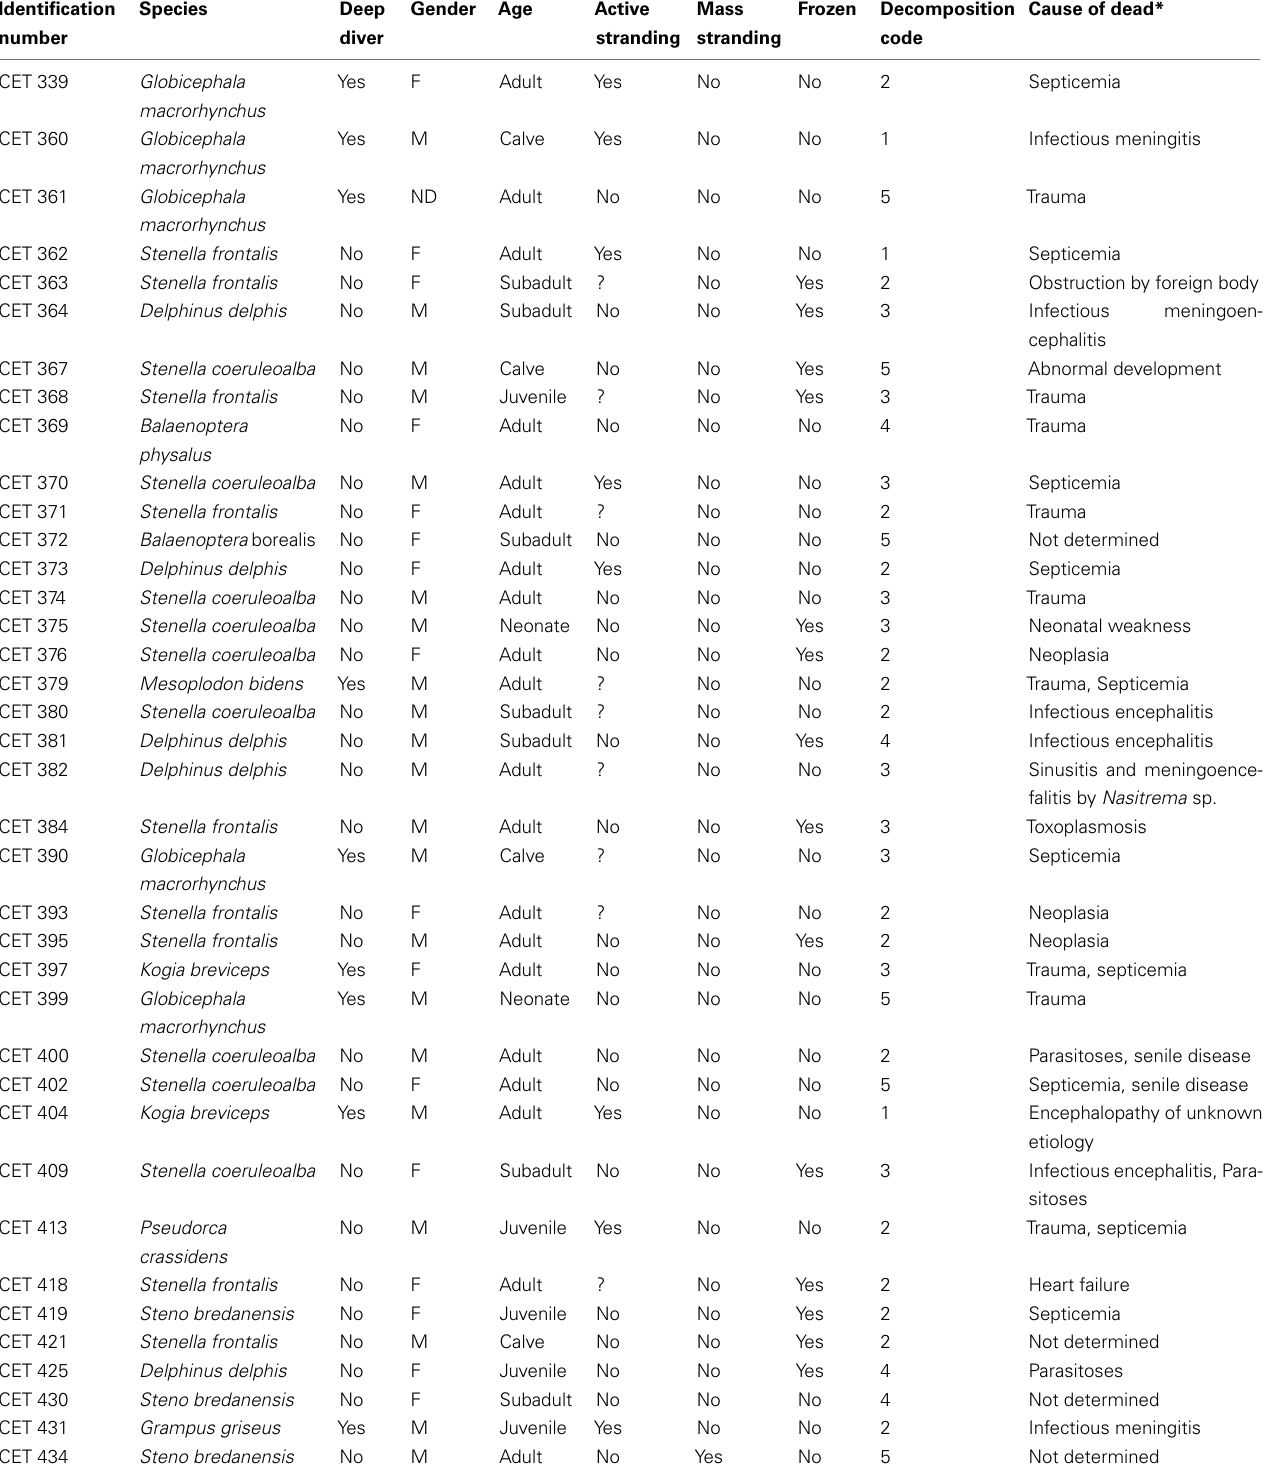
Table 1 | Identification number of the marine mammals included in the study, biological information, stranding circumstances, storing conditions, decomposition code, and most likely (*) cause of dead established by individual pathological